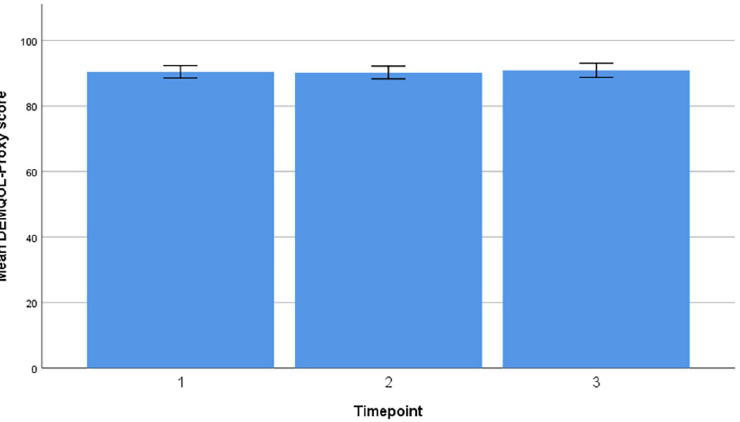
Fig 1. Timeline and change in mean scores (DEMQOL-Proxy).